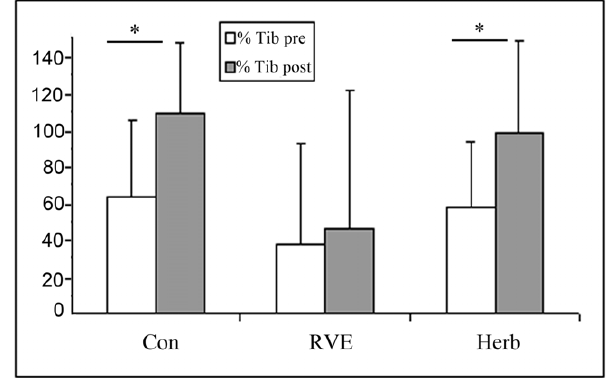
Figure 6. ‘‘FEM S’’ femoral systolic velocity changes were in the same proportion as stroke volume. There was no significant difference in the drop in FEM S (i.e., stroke volume) pre- and post-HDT tilt. Differences in vasomotor responses between the groups were not related to changes in cardiac output. This confirmed that each area provides a specific response that is due to local morphological or functional disturbances.